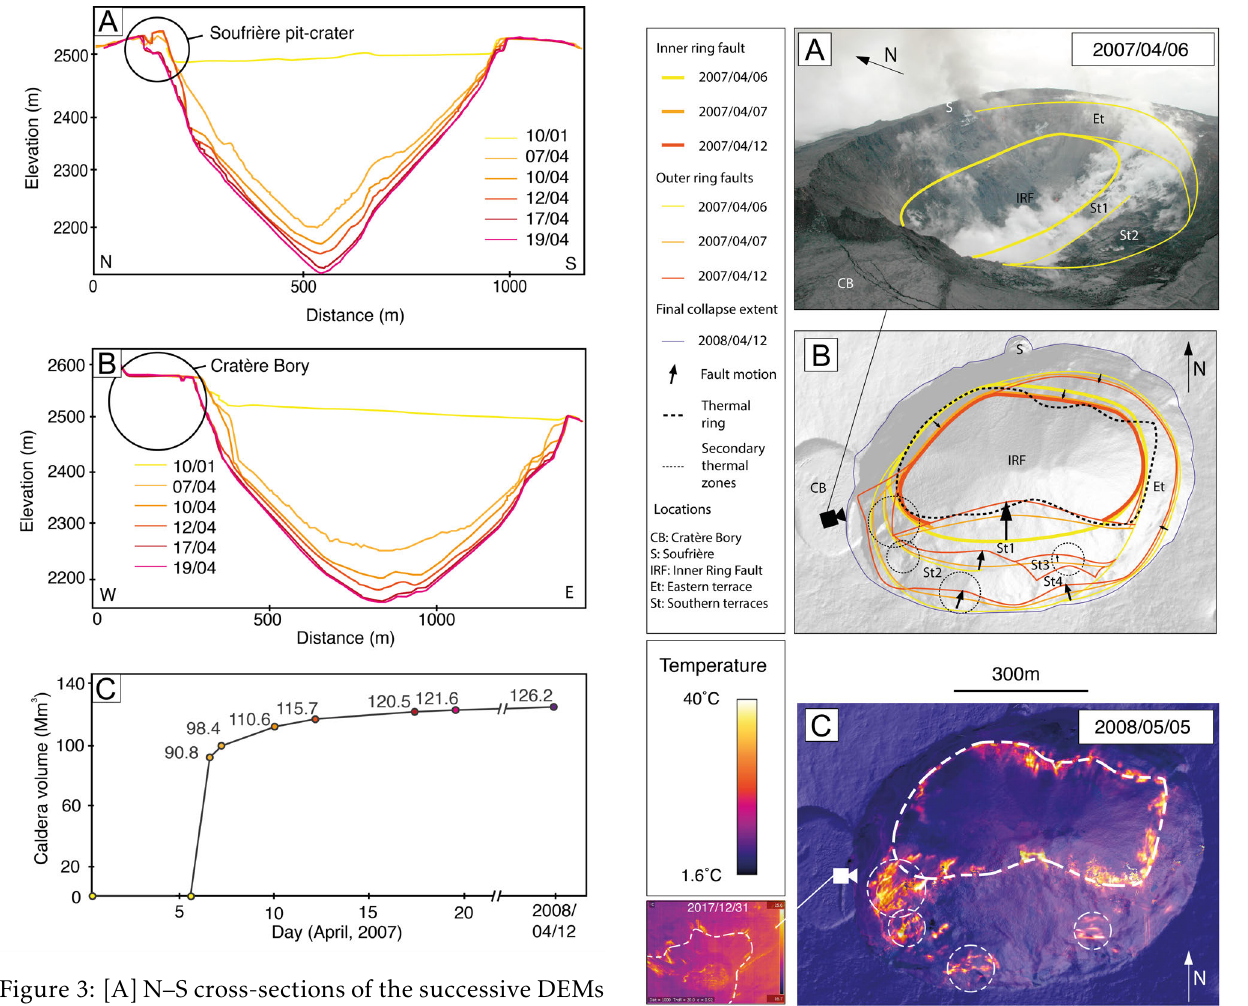
Figure 4: [A] Interpreted aerial photograph, courtesy of Peloton de Gendarmerie de Haute Montagne (PGHM), from the west of the Cratère Dolomieu on April 6 th , 2007. [B] Temporal and spatial evolution of the struc- tures associated with the April 2007 Cratère Dolomieu collapse, as identified on [A] and on Figure 2. Note the progressive appearance of the terraces associated with development of the outer ring faults, with Et, St1 and St2 created between April 5 th and 6 th , St3 created be- tween April 6 th and 7 th , and St4 created between April 7 th and 12 th . [C] Thermal orthoimage of the Cratère Dolomieu on May 5 th , 2008. The inset shows a thermal image of the caldera taken from the west on December 12 th , 2017. subsided and moved northward, giving the IRF a kid- ney shape. The other terraces had also moved towards the centre of the caldera (Figure 4B) and the fault at the base of St2 had significantly propagated